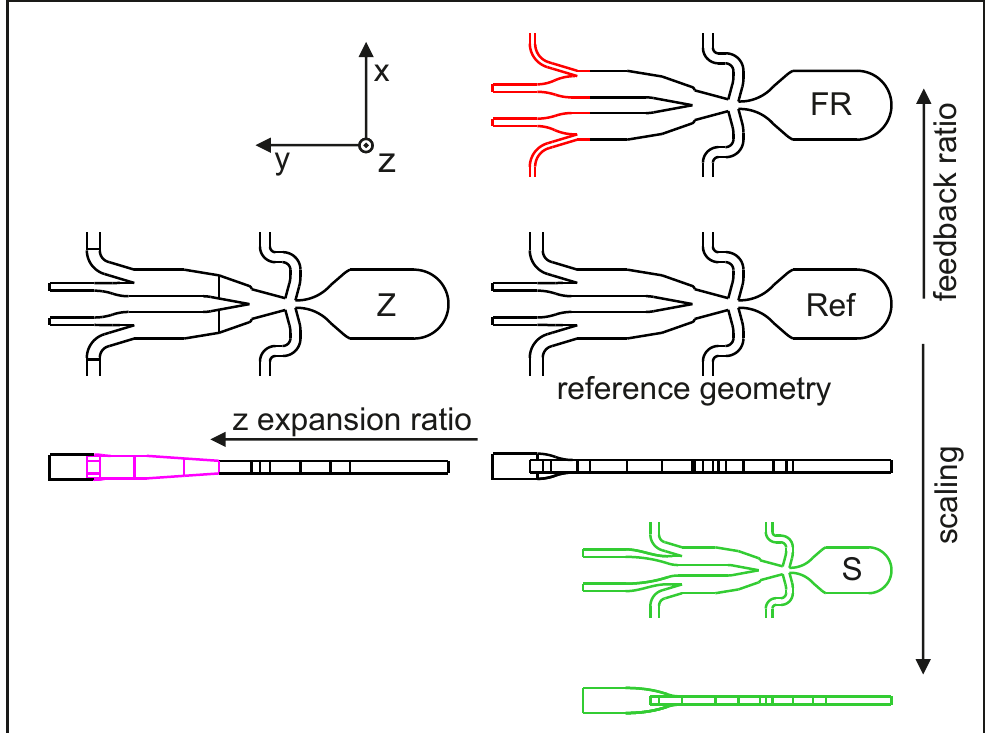
Figure 4. Family of oscillators investigated in the experiments.